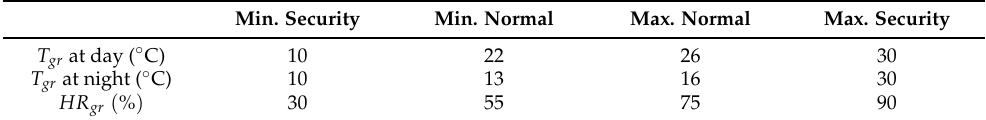
Table 1. Greenhouse climate limits. Min. Security Min. Normal Max.